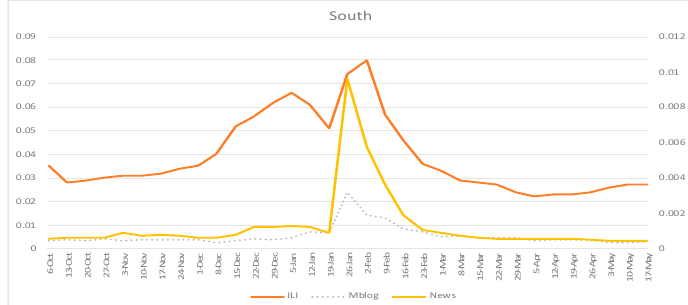
Figure 1. Weekly time series of ILI rates from the Chinese National Influenza Center (CNIC), fraction of influenza-related online news articles, and fraction of influenza-related microblogs: South of mainland China, 6 October 2019–17 May 2020. ILI = influenza-like illness rates from CNIC; Mblog = fraction of influenza-related microblogs; News = fraction of influenza-related online news articles.